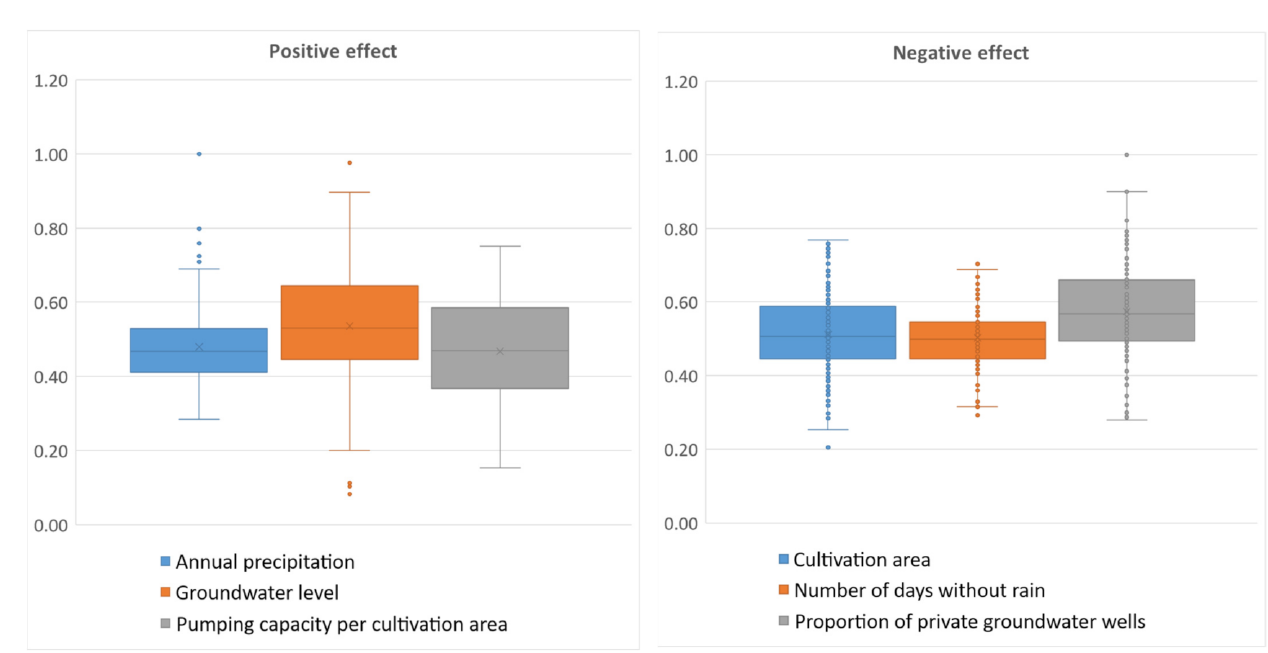
Figure 3. Boxplots of the study